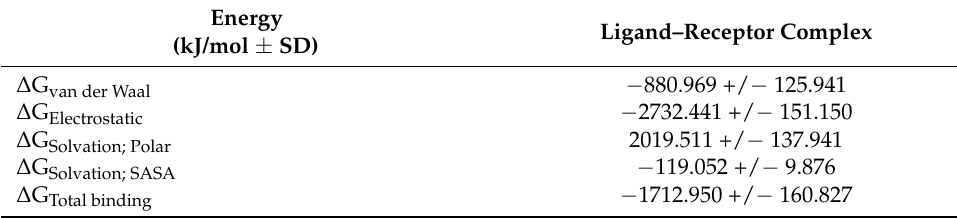
Figure 10. Conformational analysis of MD-simulated multitope vaccine/TLR-2 complex. Overlaid snapshots of the ligand–protein complex at 0 ns and 50 ns of the MD simulation runs. The vaccine and TLR-2 proteins are represented in red and blue cartoon 3D-representation, respectively, where the initial and last extracted frames are obtained at 0 ns (dark colors) and 100 ns (light colors). Table 8. Total binding-free energies and individual energy term ( ∆ G Total binding ± SD) concerning the designed multitope vaccine at TLR-2 protein binding